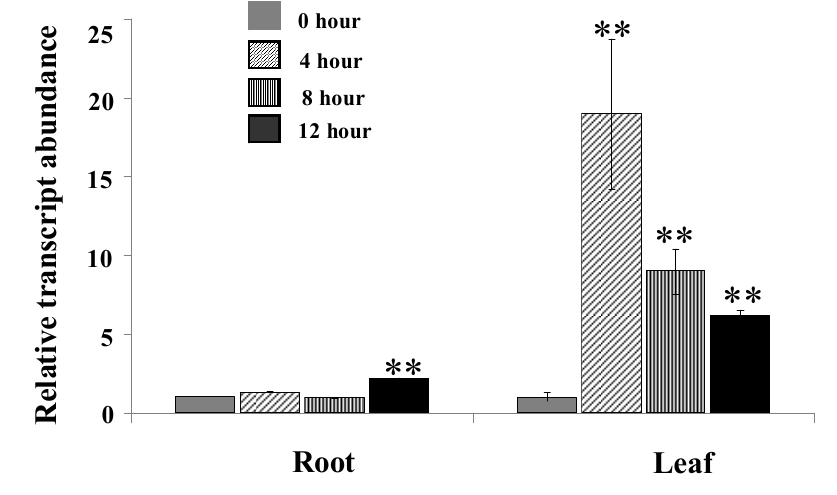
Figure 2. Quantitative real-time PCR analysis of MpCHI expression under salt stress. Leaf and root samples were collected at 0, 4, 8, and 12 h after 500 mM NaCl treatment. ** p < 0.01 by U test. Bars represent SD ( n =